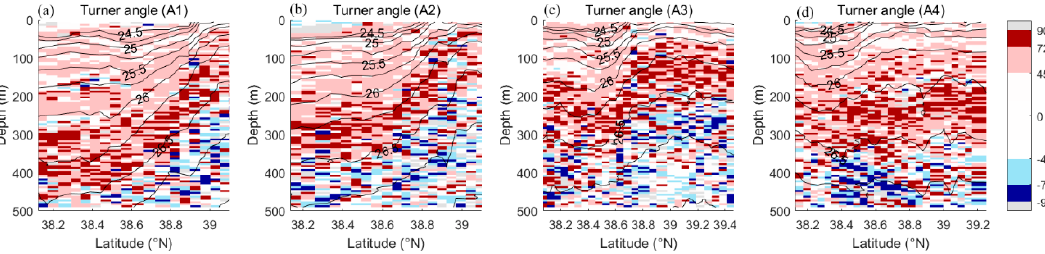
Figure 6. ( a – d ) Turner angle (Tu) (shading in °) of the four sections. Contours indicate the potential density (kg/m 3 ) with 0.25 kg/m 3 intervals.